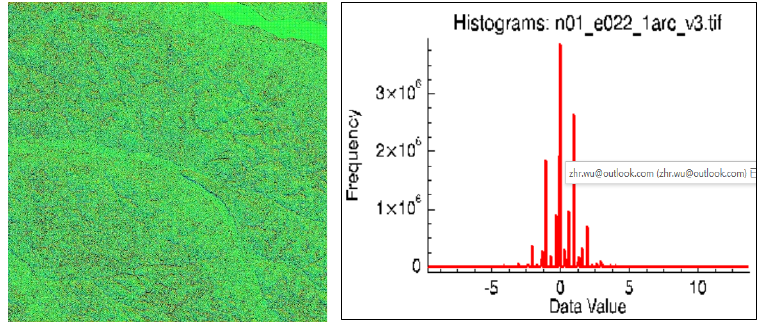
Figure 6 The difference image and histogram of the test DEM